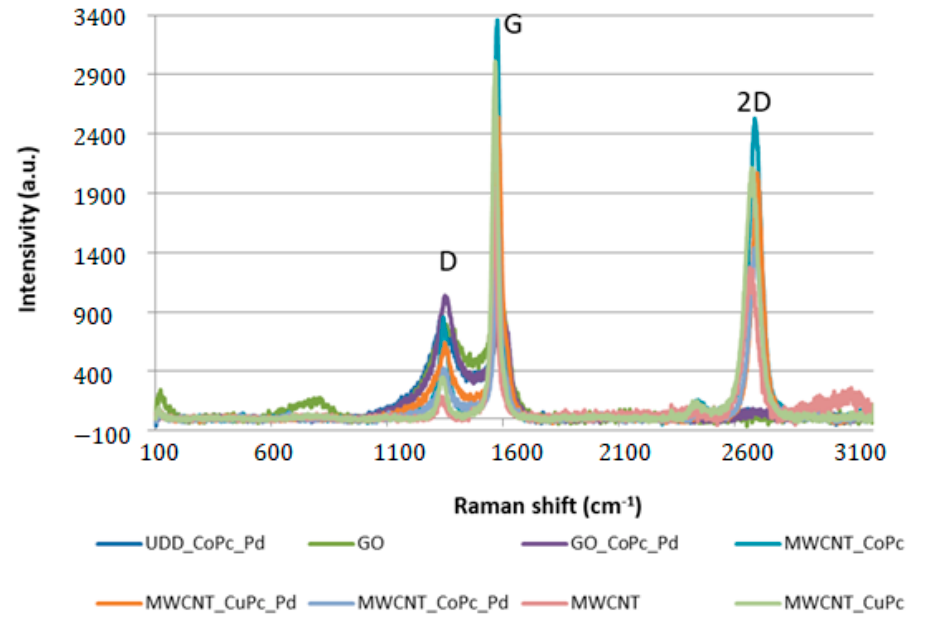
Figure 2. Raman spectra of the synthesized catalysts and the initial carbon supports. Two main peaks located at 1330 (D band) and 1590 cm − 1 (G band) are related to the disordered carbon and graphitic carbon peak, respectively. The process of doping the surface of carbon materials is usually accompanied by the formation of defects [34]. Table 2 shows the results of spectral analysis. Table 2. Results of the Raman spectra of the synthesized catalysts and initial carbon supports.